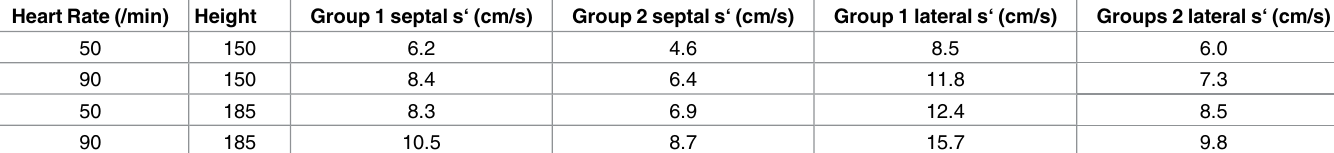
Table 8. Predicted s‘ in Group 1 and Group 2 based on combinations of two different heart rates and